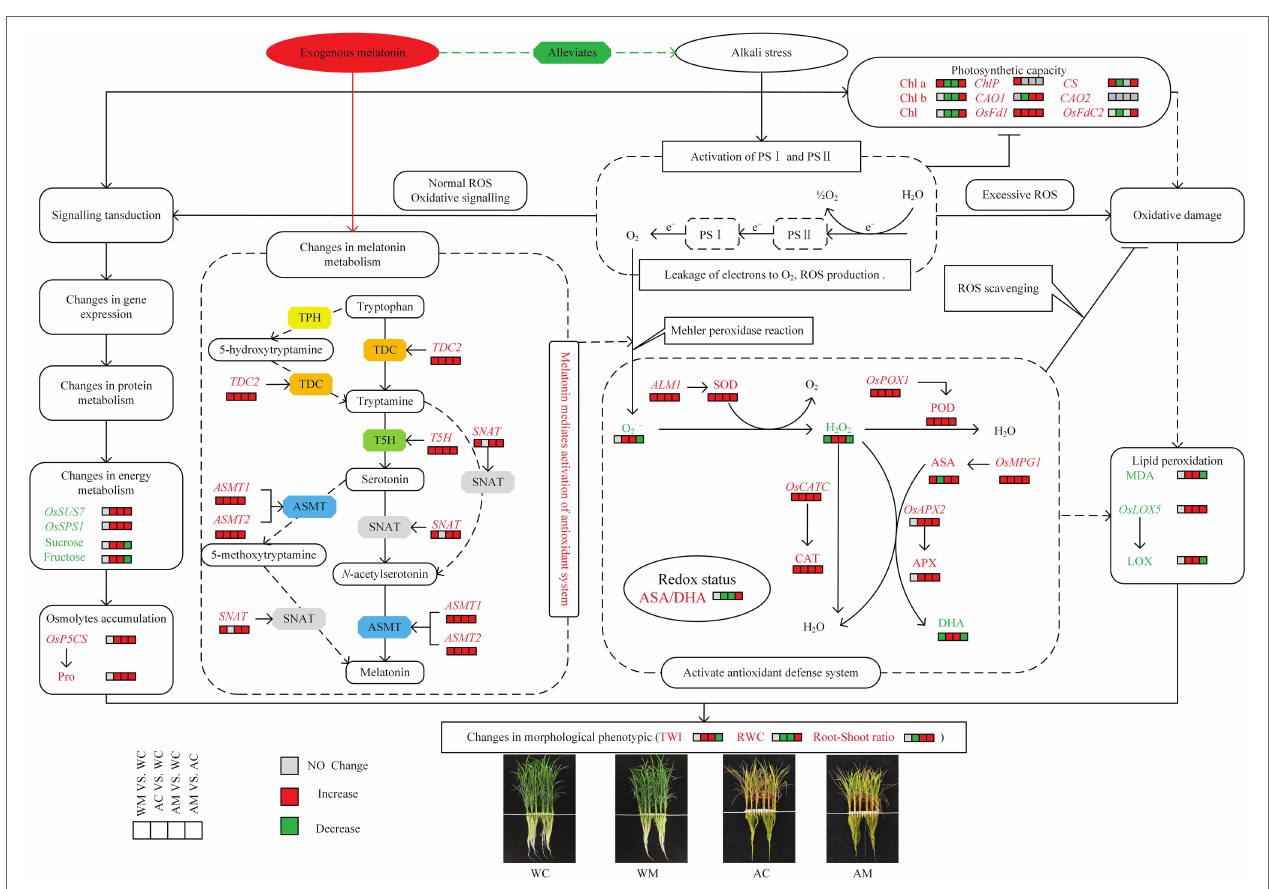
FIGURE 10 | Cell metabolism model of exogenous MT on alleviating effects of rice seedlings under alkaline stress. The solid (dotted) black arrows and the solid (dotted) terminated lines represent direct (indirect) positive influence and direct (indirect) negative influence, respectively. The red and green boxes represent a significant increase and decrease in the measured indicator content in a certain MT treatment, respectively. The gray boxes indicate no significant changes in the measured indicator content between non-stressed and stressed